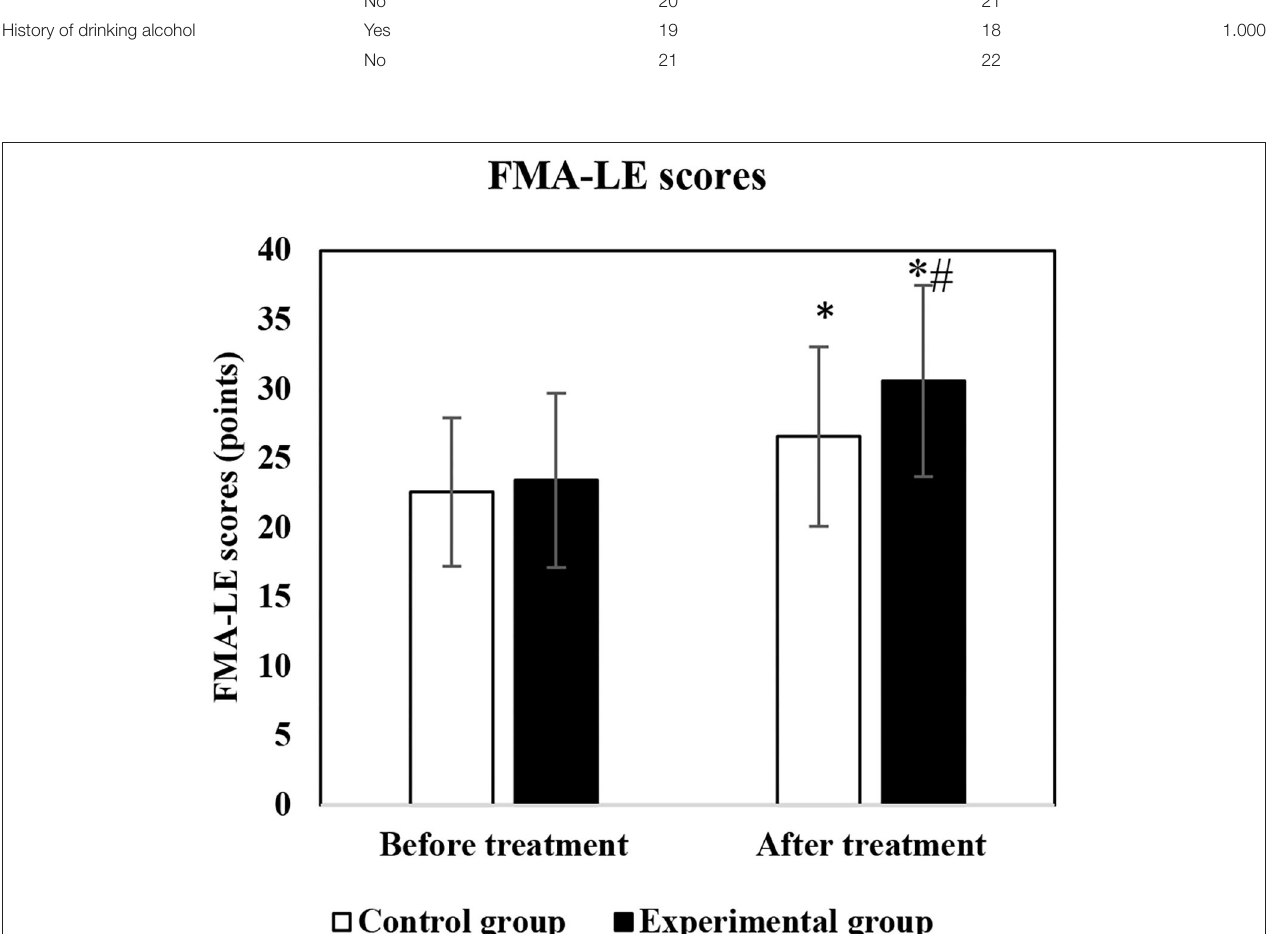
FIGURE 11 | Comparison of FMA-LE scores before and after treatment. * and # indicated that the difference was statistically significant compared with the data before treatment and that in the control group, respectively ( p < 0.05).